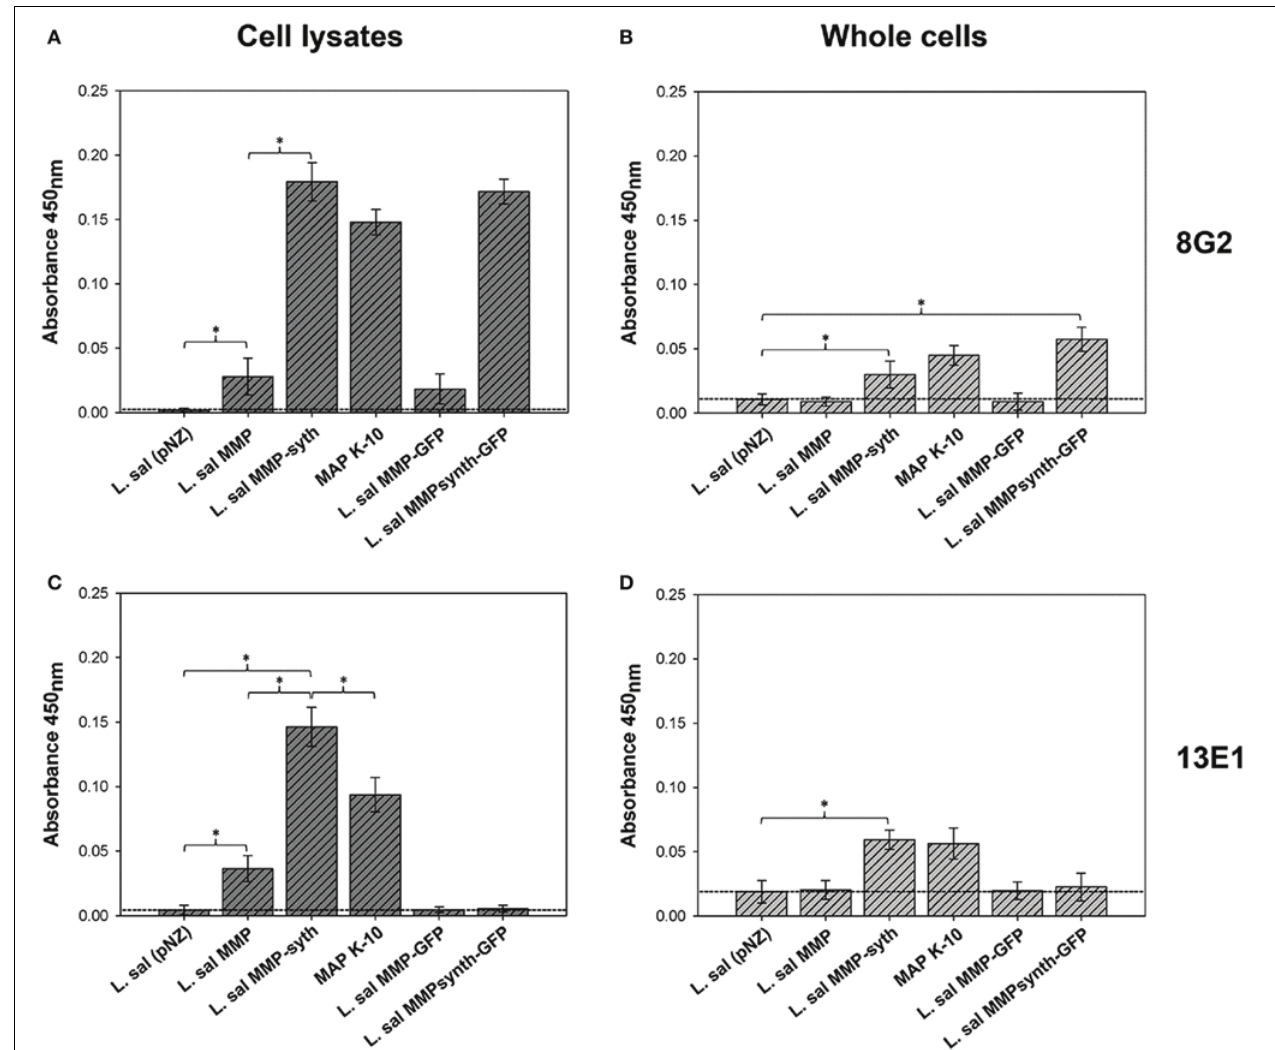
FIGURE 3 | Comparative ELISA analysis of recombinant L. salivarius cell-lysate and whole-cell against MAP K-10, using two monoclonal antibodies directed against MMP. The 8G2 antibody detects MMP (A,B) . The mAb13E1 antibody detects a discontinuous epitope on MMP ( C,D) . The